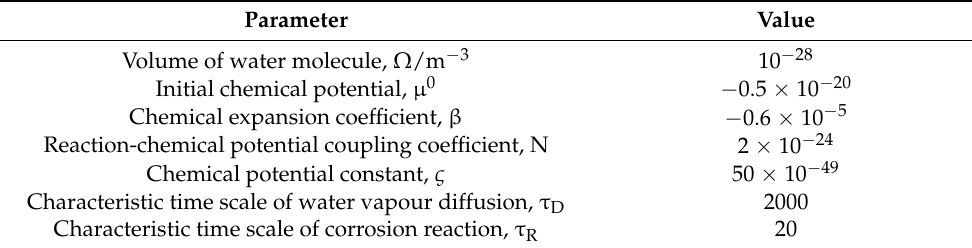
Table 1. Main thermodynamic parameters used in the